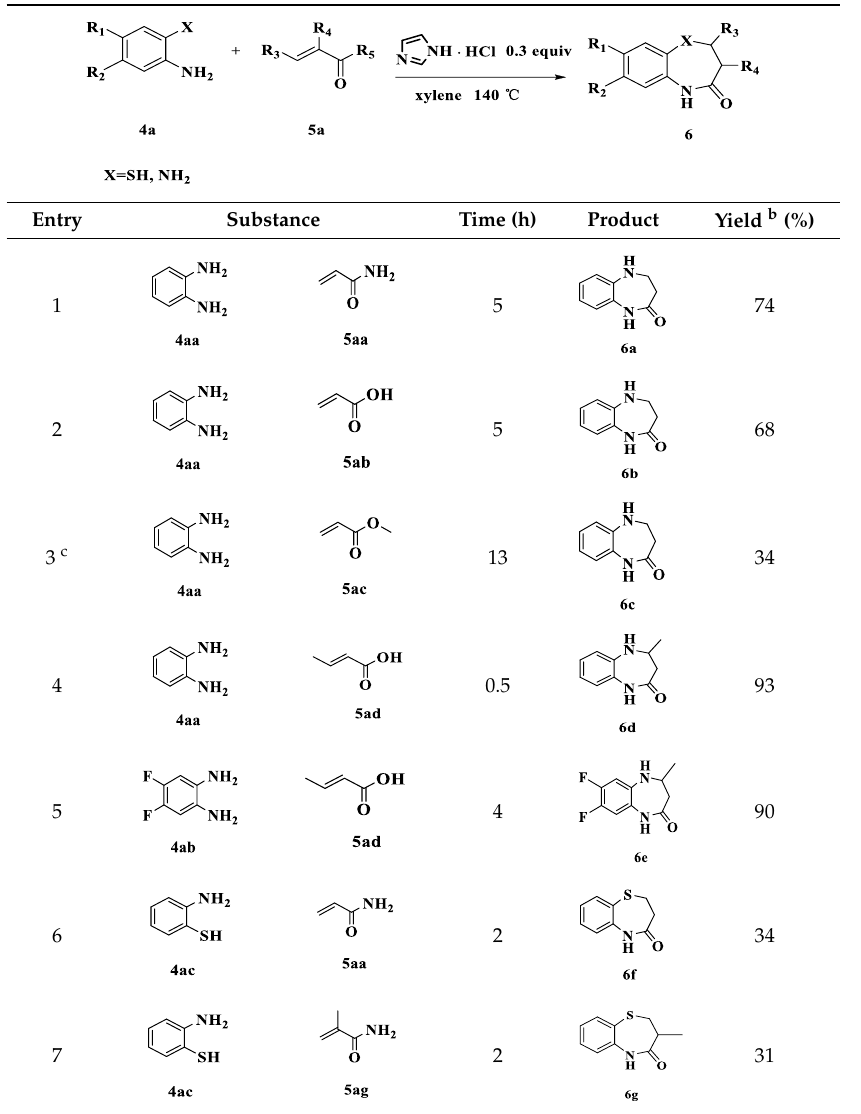
Table 6. Substrate scope of substituted 1,3,4,5-tetrahydro-2H-1,5-benzodiazepine-2-ones and substituted